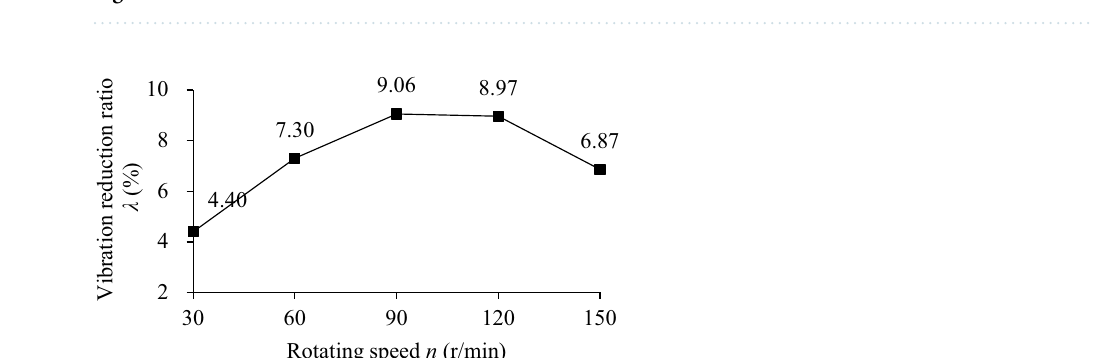
Figure 22. Influence of n onTEC.